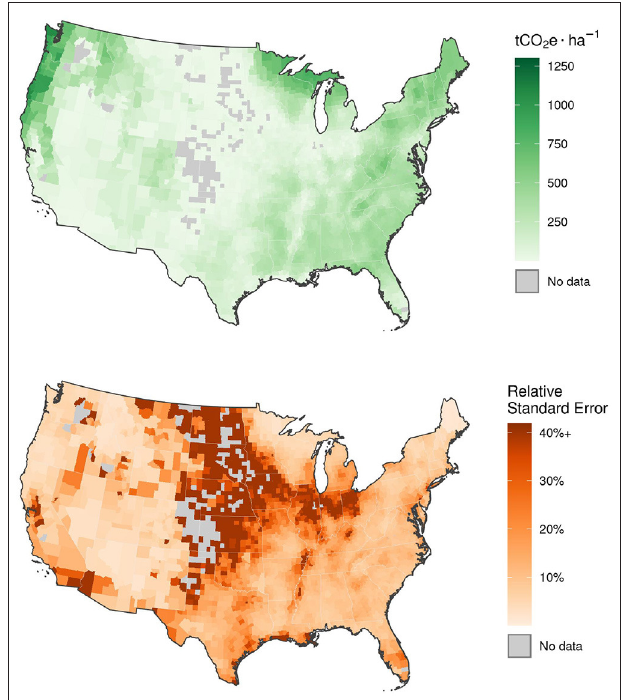
FIGURE 3 | County-level estimates of mean forest carbon density (tons CO 2 equivalent per hectare, tCO 2 e · ha − 1 ) produced by the spatial Fay-Herriot model with climate predictors (top) , and associated relative standard error (%; bottom ). Gray shaded counties indicate no forested FIA plots were encountered in the county during the most recent current volume inventory, i.e., post-stratified estimator of total forest carbon and associated variance for the county are equal to